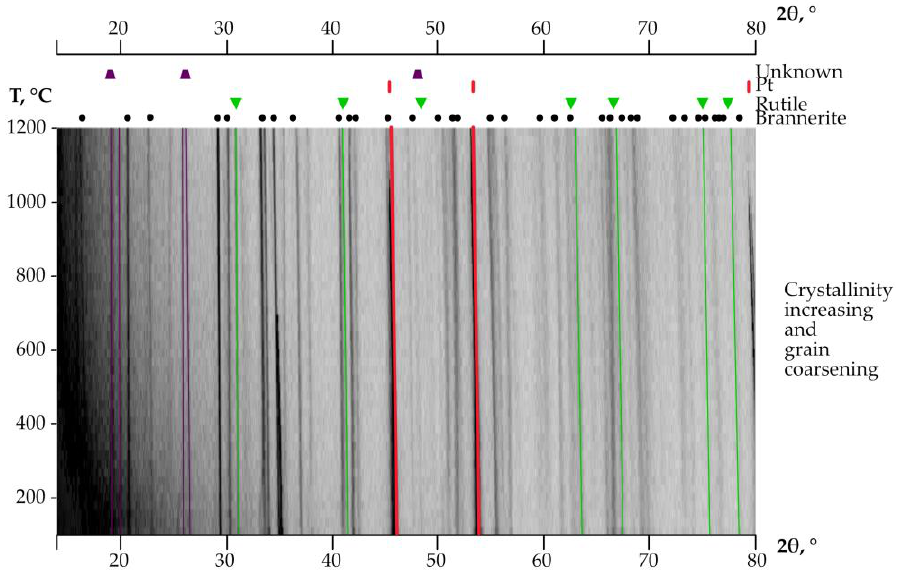
Figure 5. The content of the uranium oxide phases formed during the heating of metamict brannerite ( a ). XRD pattern obtained after cooling ( b ).